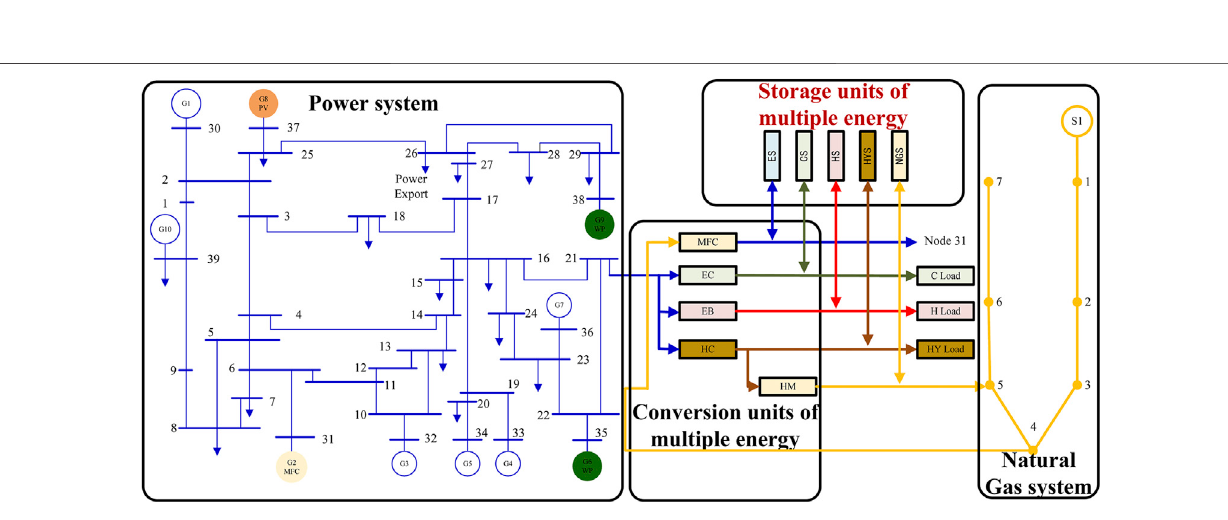
Frontiers in Energy Research |